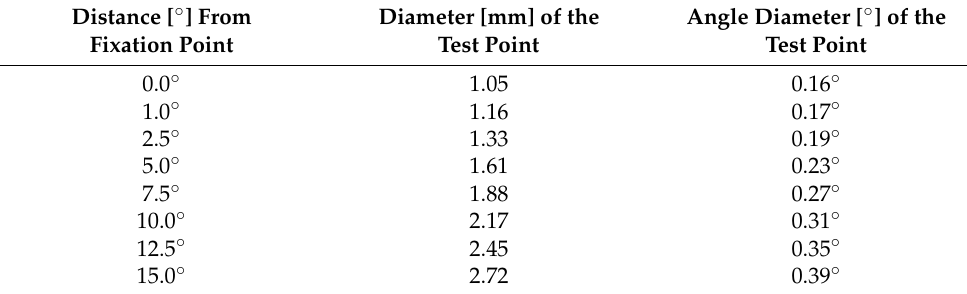
Table 2. Various test point sizes in relation to position.